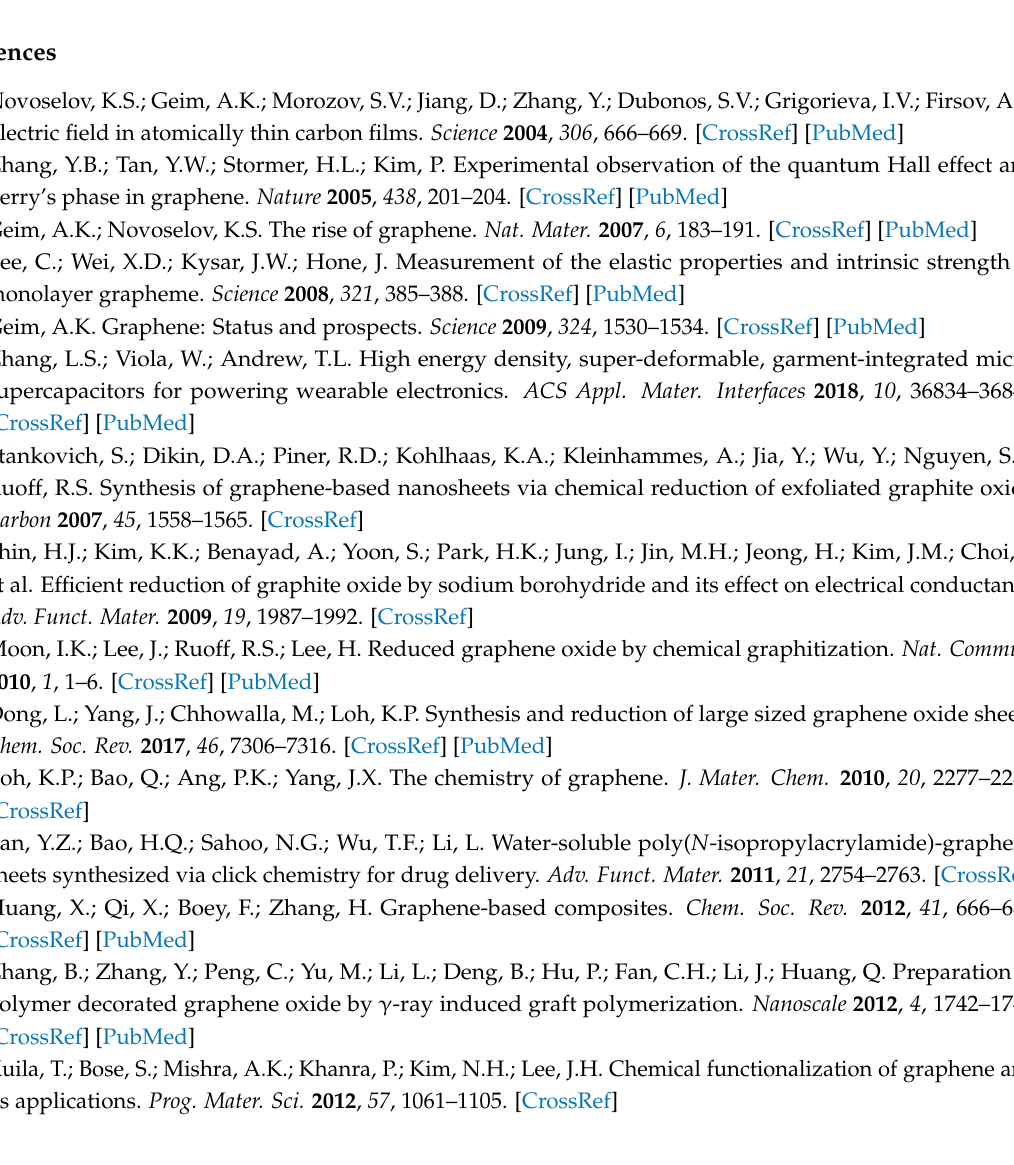
Figure S1: GPC curves of PFcMAss homopolymer and free PFcMAss polymer during surface-initiated ATRP, Table S1: Elemental analysis of TRIS-GO-Ini, GO-PFcMAss, and GO-PFcMAss-AuNPs obtained from XPS, Figure S2: Photos of solutions of AuNPs prepared by Brust-Schiffrin protocol with (A) and without (B) the addition of TRIS-GO-PFcMAss, Figure S3: 1 H NMR spectra of PFcMAss and PFcMAss-AuNPs in CDCl 3 and the photo (inset) of PFcMAss in toluene (0.1 mg/mL), Figure S4: FT-IR spectra of PFcMAss and PFcMAss-AuNPs, Figure S5: Tapping mode AFM images with section analysis of PFcMAss-functionalized AuNPs. and G.L.L.; validation, M.Y., H.Y.Z. and C.F.; formal analysis, W.H.Q.; investigation, W.H.Q.; resources,